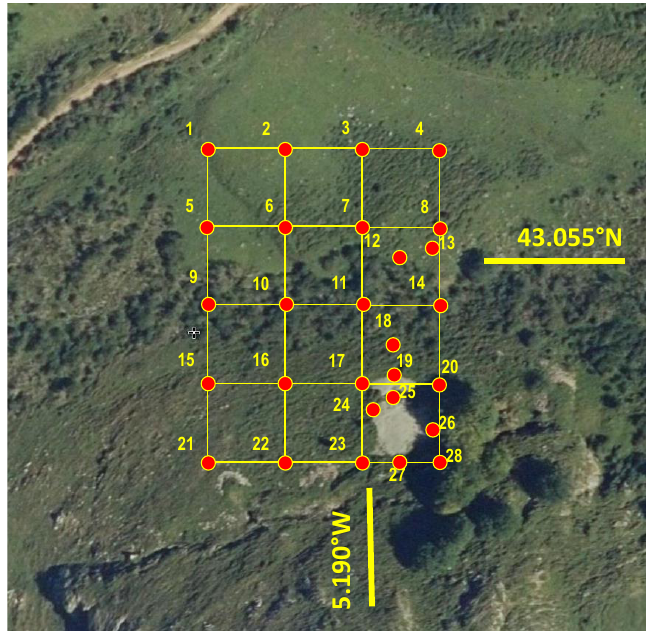
Figure 2. Soil sampling grid (scale: 25 m between samples in the regular grid).